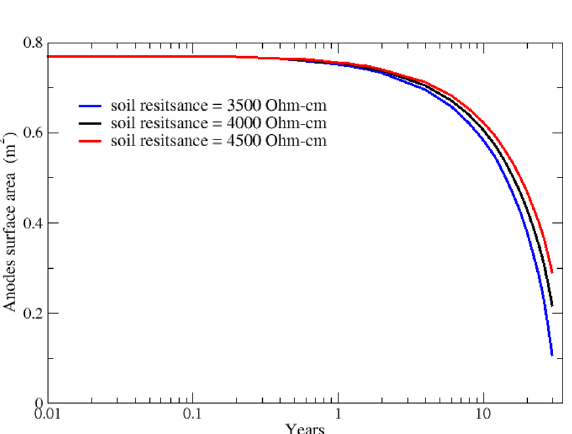
Figure 5. Surface area reduction for all anodes in soils with different resistivity